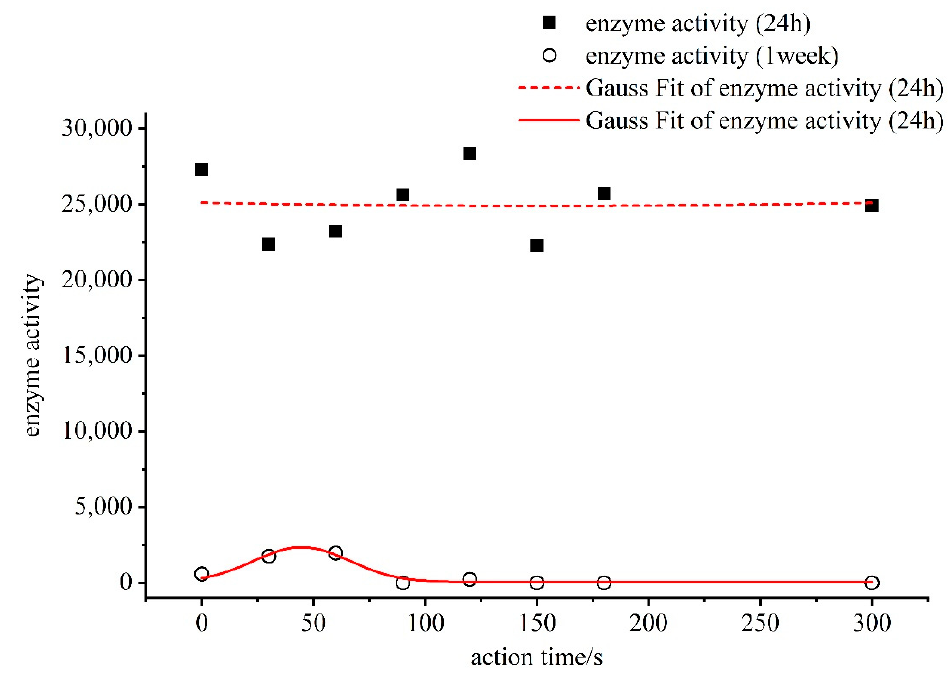
Figure 5. The diagram of α -amylase enzyme activity affected by plasma after 24 h and 1 week.